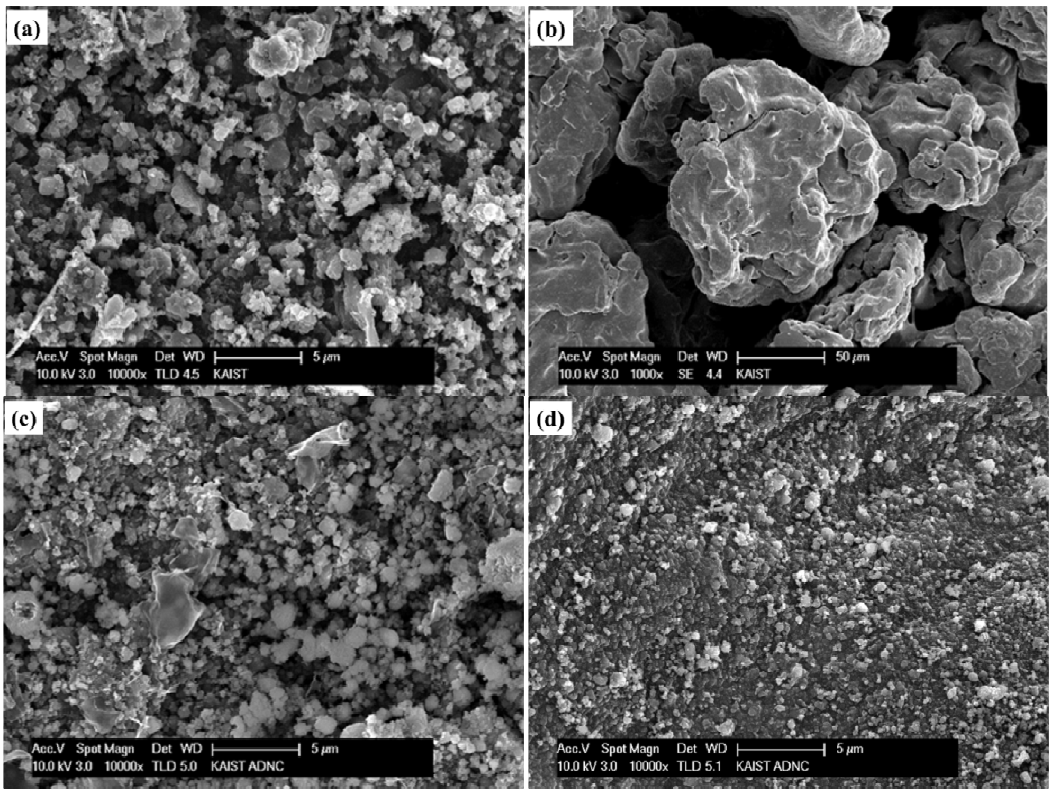
Figure 2. Scanning electron microscope (SEM) images of: ( a ) initial amorphous boron; ( b ) initial Fe; ( c ) the ball-milled amorphous boron and Fe mixture; and ( d ) the supernatant of the ball-milled amorphous boron and Fe mixture dispersed in